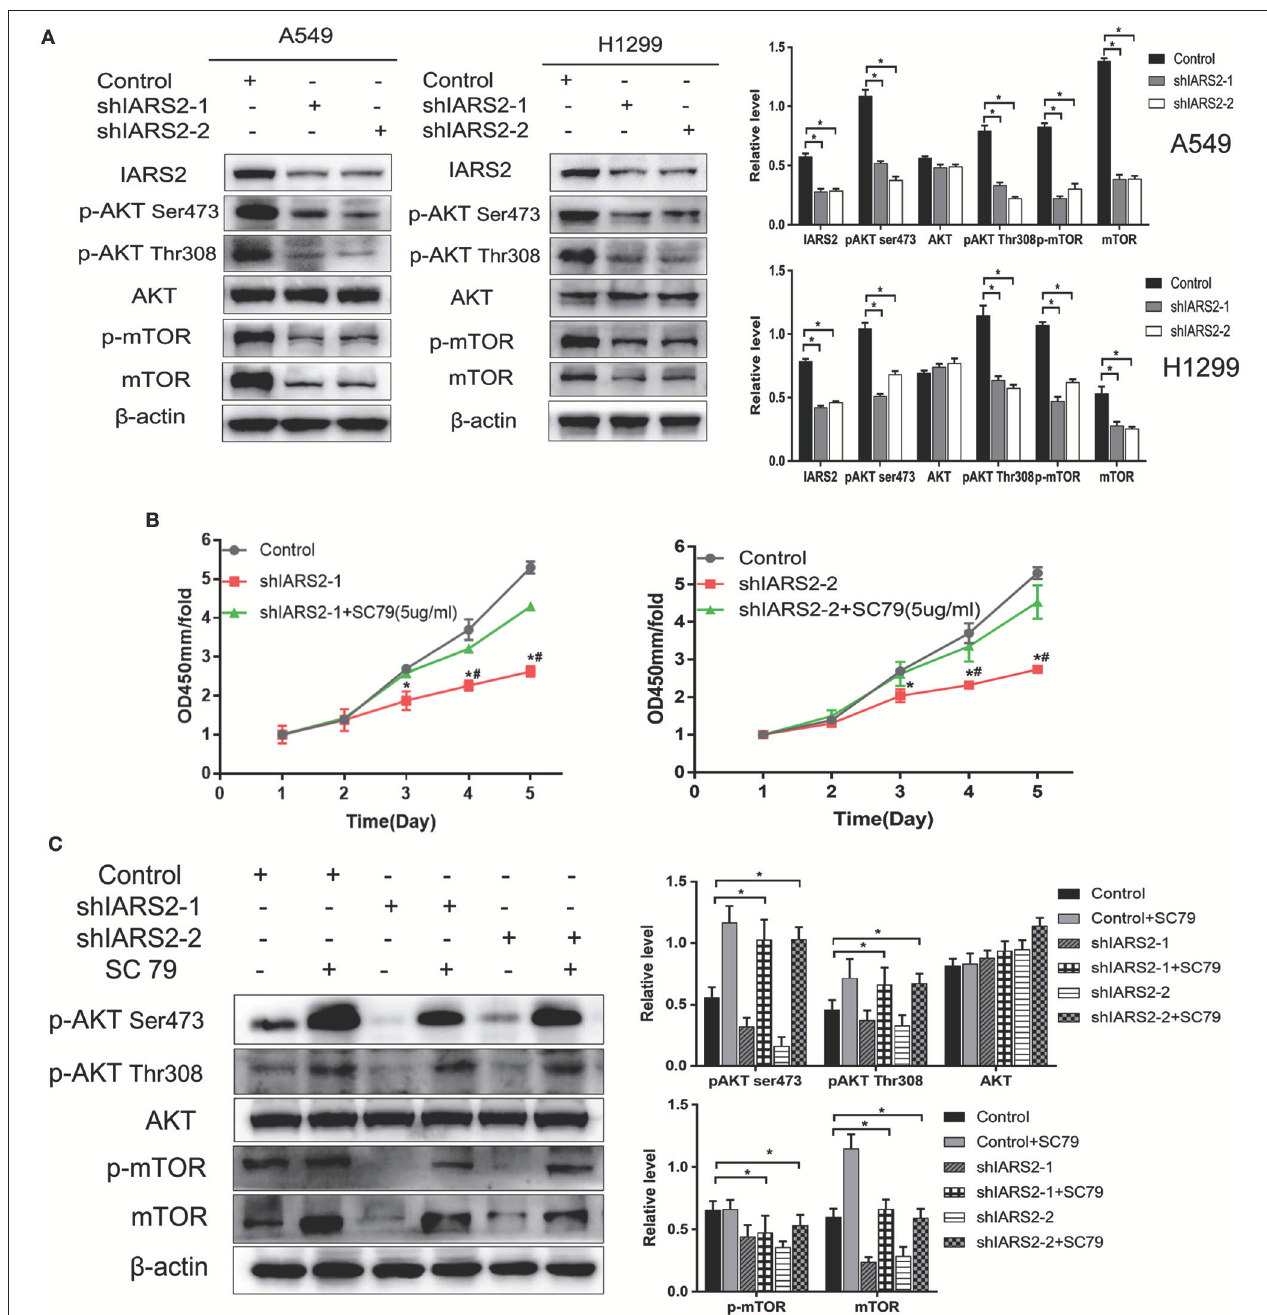
FIGURE 6 | Correlation between IARS2 and AKT/MTOR signaling. (A) IARS2 activated AKT/MTOR signaling in A549 and H1299 cells. (B,C) The AKT activator SC79 partially restored AKT/MTOR signaling in A549 cells. CCK-8 assays and western blotting were performed to determine protein phosphorylation status after exposure to SC79 (5 µ g/mL; 48 and 1h, respectively). * , # p < 0.05. (*comparison with the control group; #comparison with the applied sc79 group).